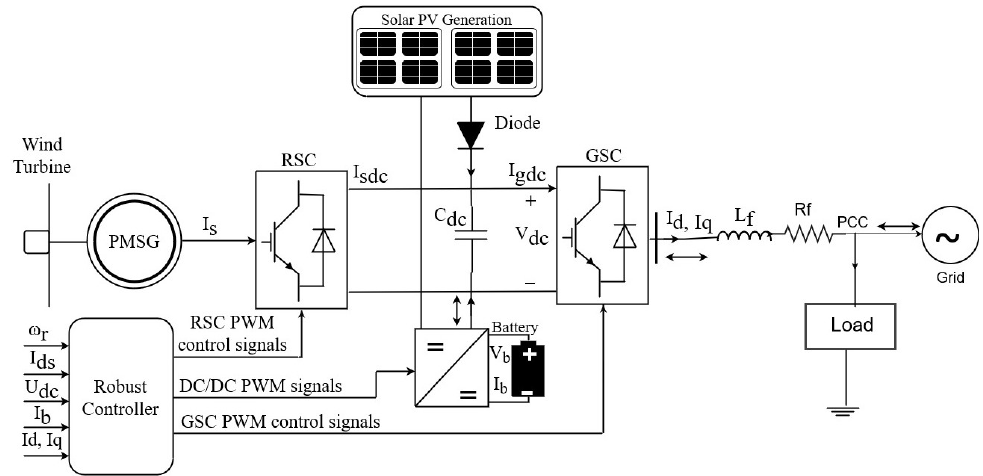
Figure 1. PV/wind/battery microgrid